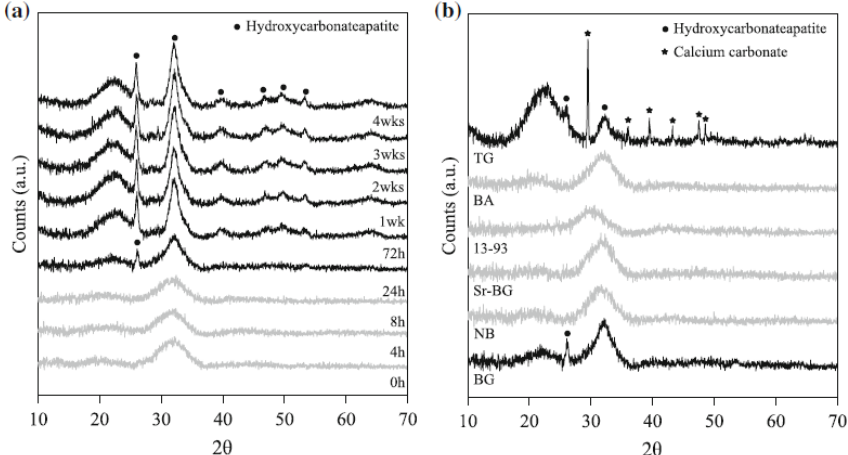
Figure 3. XRD spectra of (a) 45S5 glass particles (size 45–90 μ m) after 0 to 4 weeks of immersion in SBF and (b) different silicate glass compositions after 24 h immersion in SBF. All of the glasses were produced by melting, except for the glass TG, which was obtained by sol-gel process. Reproduced